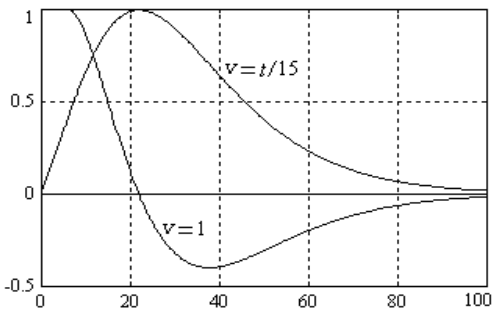
Figure 31. Responses y ( t ) to a step and ramp